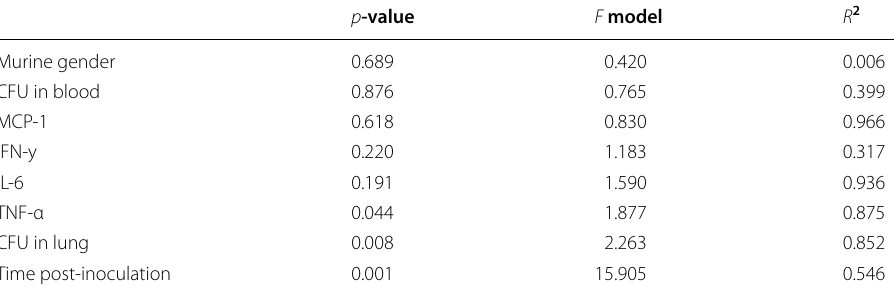
Table 1 Time post-inoculation, pulmonary bacterial counts and TNF-α correlate to the lung microbiota over